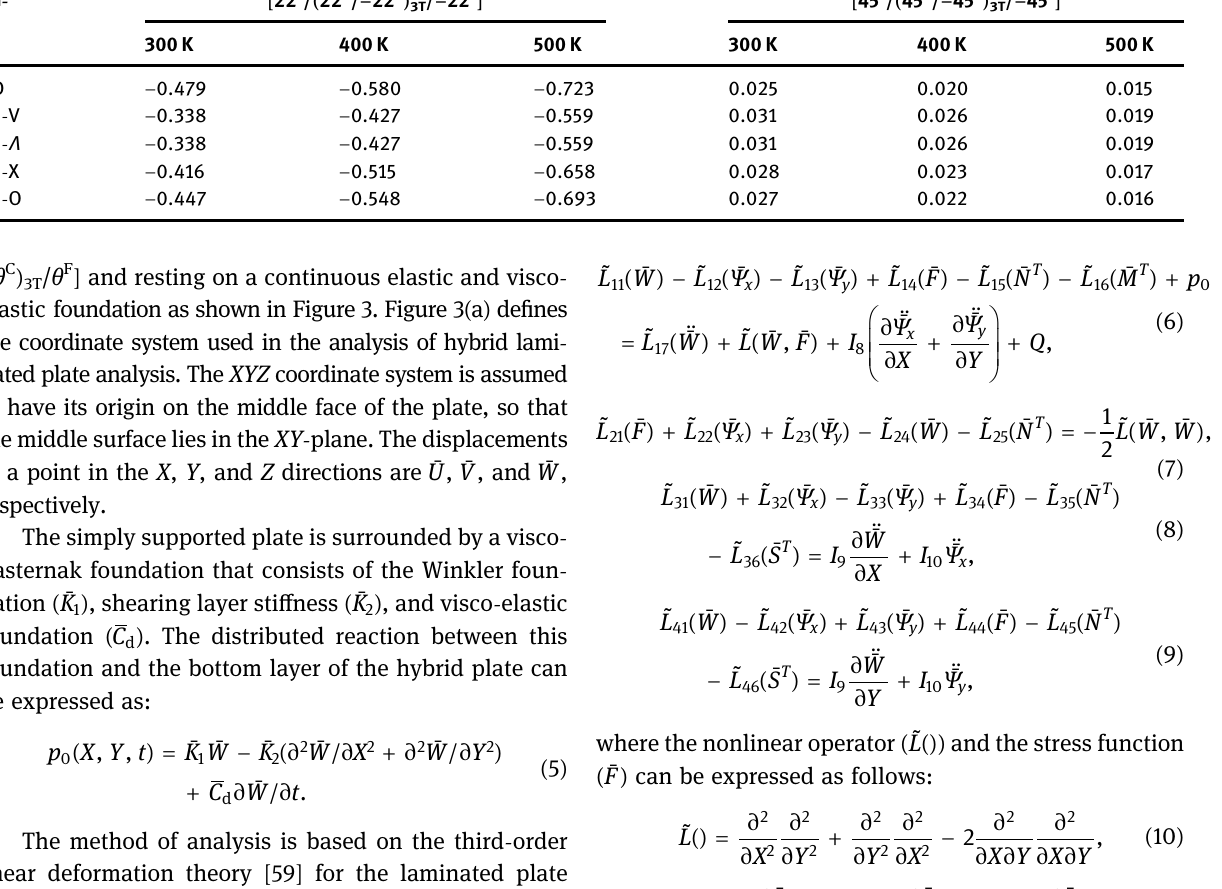
Table 4: EPR ( v e 13 ) of hybrid laminates for various temperature conditions FG -